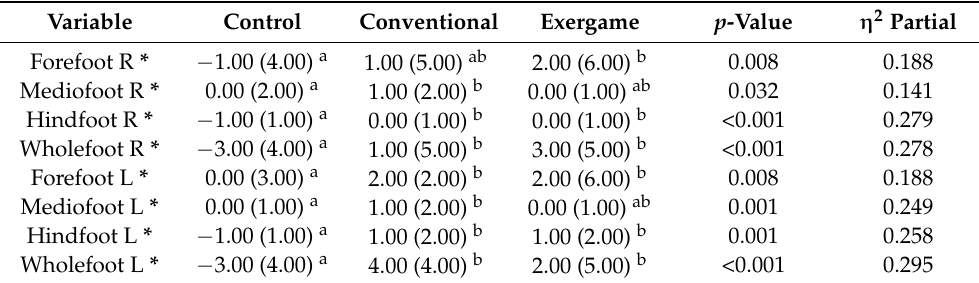
Table 5. Intergroup comparisons of changes (T1-T0) and effect size of the plantar tactile sensitivity of the older women participating in the study. Jequi é , Bahia,